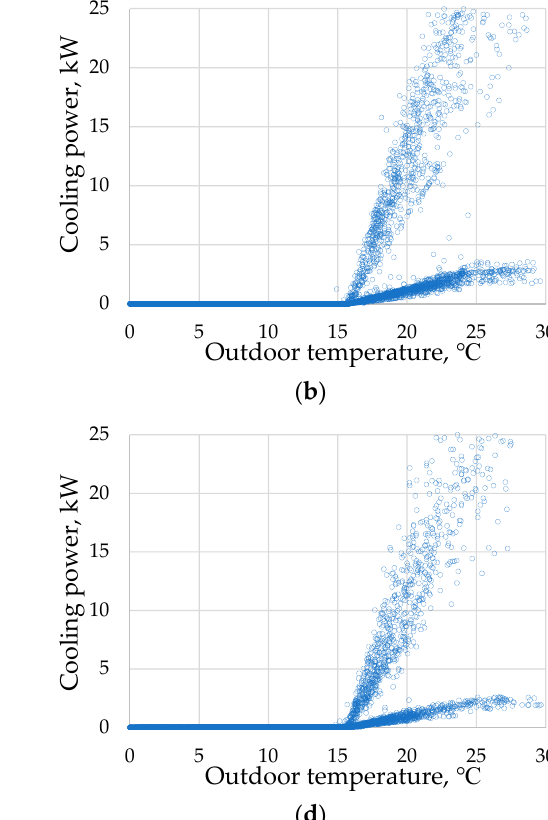
Figure 4. Illustration of the non-existing base temperature of heating degree day (HDD) for different climates; the plot of hourly heating powers ( a ) Tallinn, ( b ) Sapporo, ( c ) Paris, and ( d ) Brussels.